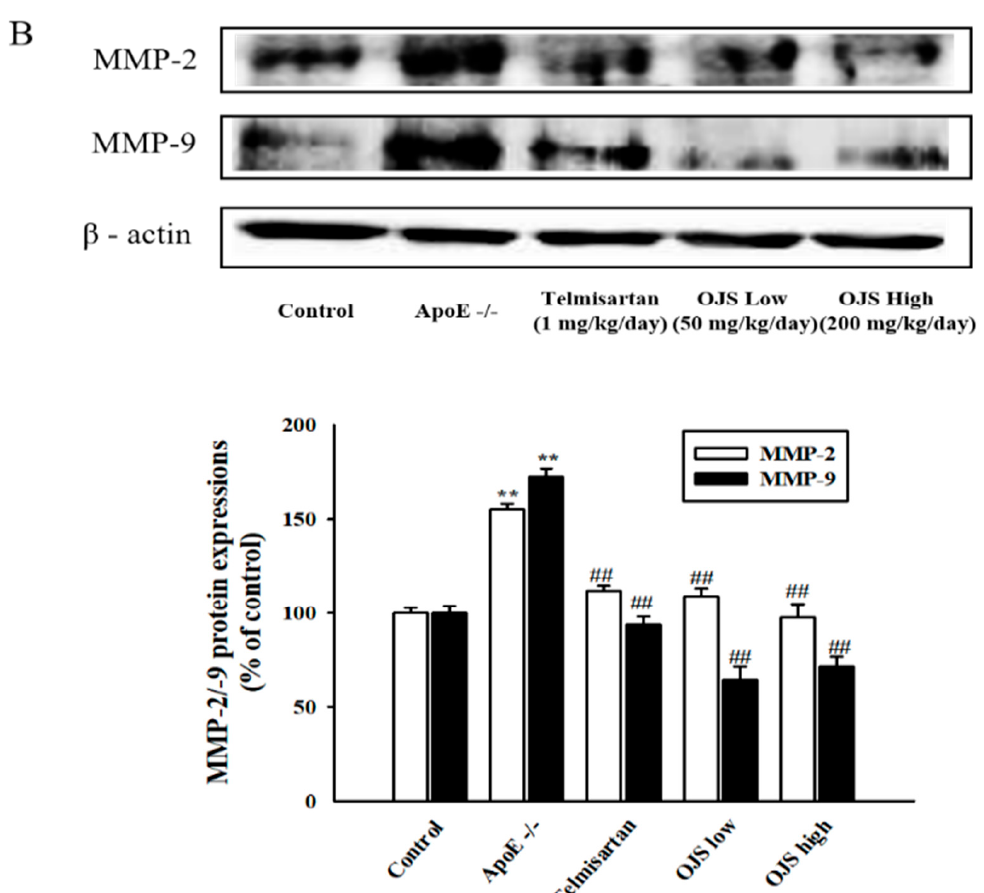
Figure 5. Effects of OJS on matrix metalloproteinases (MMP)-2/-9 expression in the aorta of ApoE − / − mice. MMP2, and MMP-9 immunofluorescence in the aorta of ApoE − / − mice ( A ). Immunofluorescence staining of MMP-2/-9 in the aorta from the control, ApoE − / − , and ApoE − / − mice treated with telmisartan groups and ApoE − / − mice treated with OJS at low or high concentrations. Protein levels of MMPs determined by Western blot analysis ( B ). Data are presented as means ± S.E. ** p < 0.01 vs. control group; ## p < 0.01 vs. ApoE − / − group.